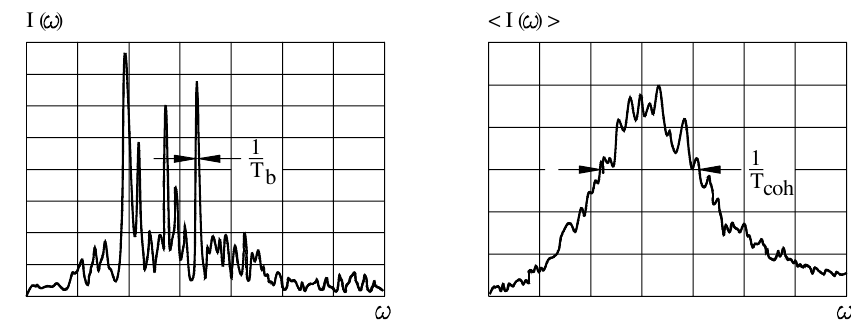
FIG. 2. Intensity spiking in the frequency domain (arbitrary units). In the single-shot spectrum shown on the left, the width of the peaks is inversely proportional to the electron bunch duration T this case the width is proportional to the gain bandwidth (cid:10)